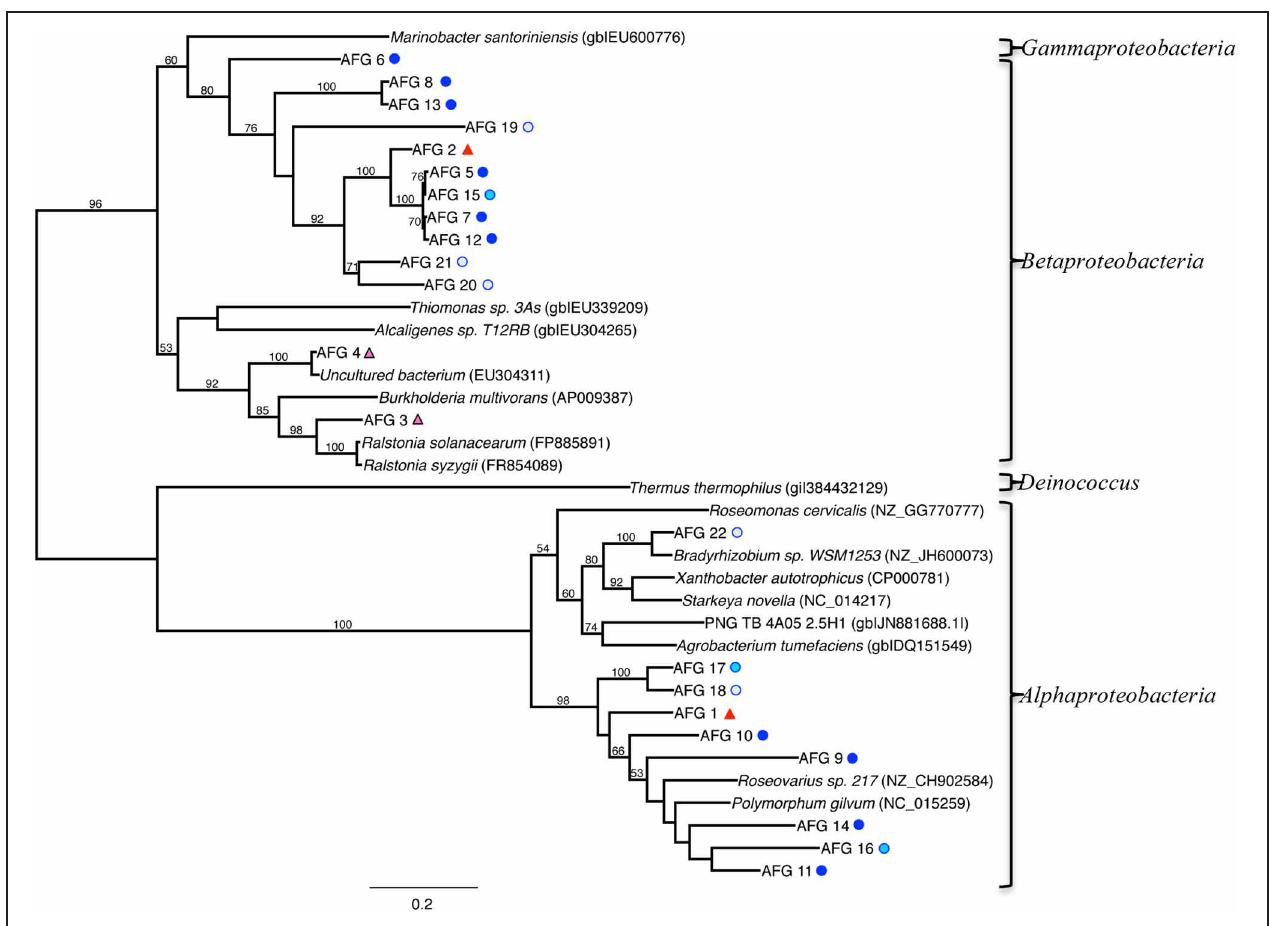
FIGURE 8 | Maximum-likelihood phylogenetic tree of closest relatives found for representatives from the aioA -like functional gene (AFG) clone libraries. AFGs are defined by a 97% similarity cutoff. Symbols next to the